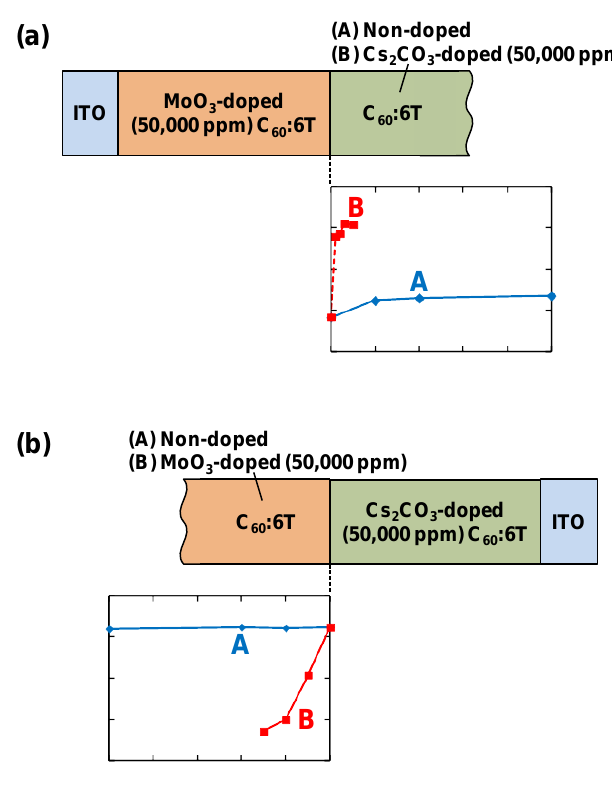
Cs CO -doped (red curve B) deposited on a MoO 2 3 (blue curve A) or MoO C :6T 60